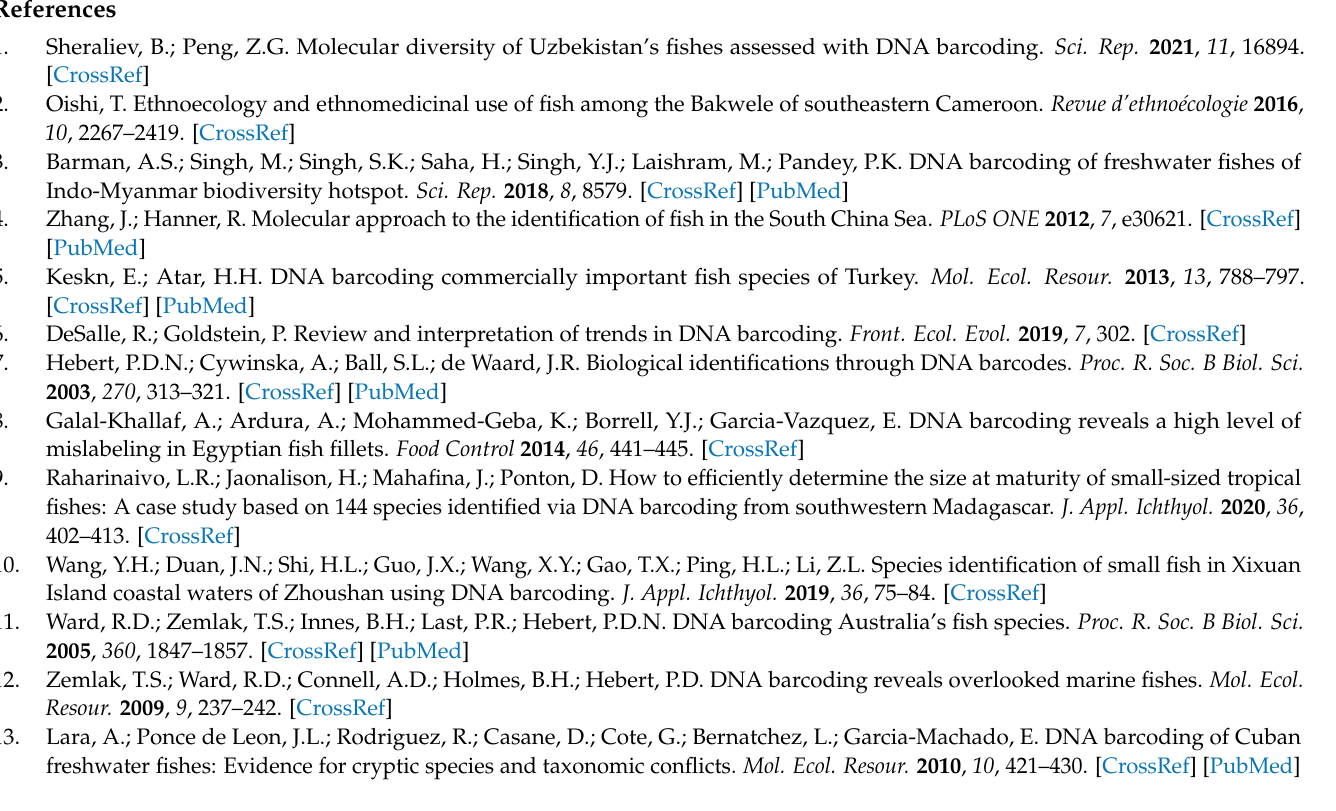
Table S3: Summary of maximum genetic distance and nearest-neighbor genetic